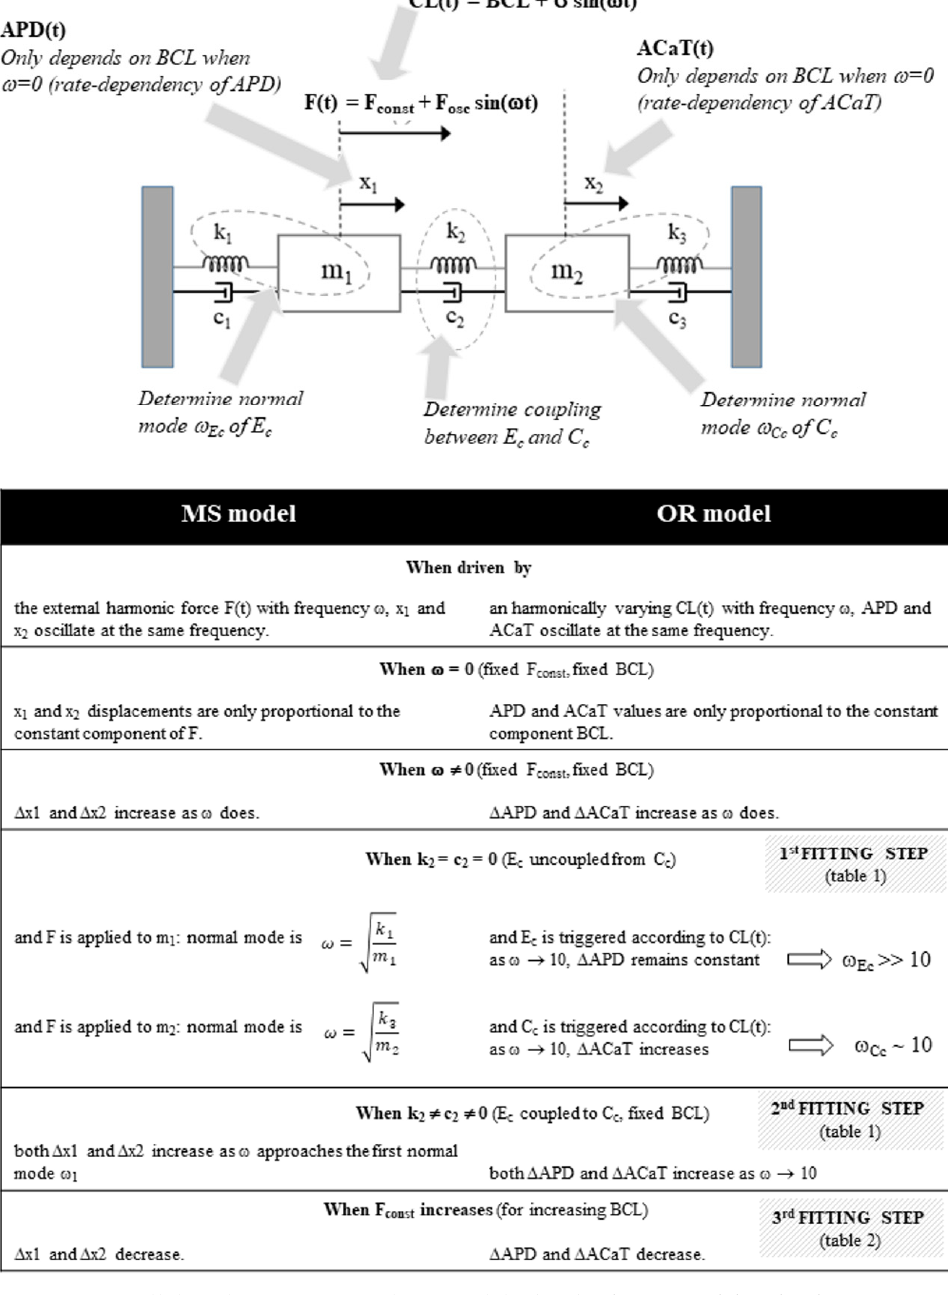
Figure 12. Parallelism between OR and MS models. ( Top ): The MS model with schematic reminds to the corresponding EC coupling players. ( Bottom ): Schematic features of the parallelism between MS and OR behavior under SVP.